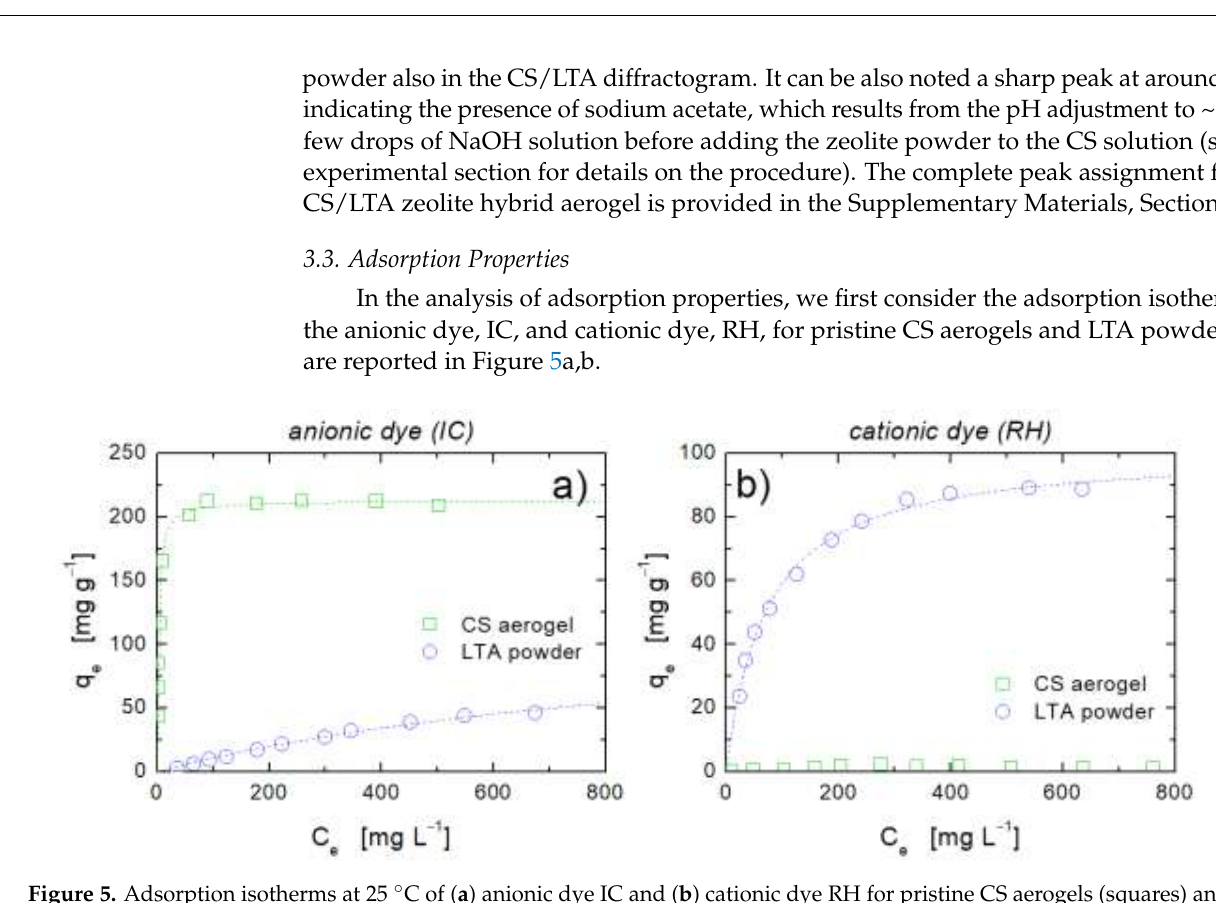
Figure 4. XRD patterns of CS, LTA powder, and hybrid CS/LTA sample at weight ratio equal to 1:1. The XRD patterns have been vertically shifted for the sake of clarity.